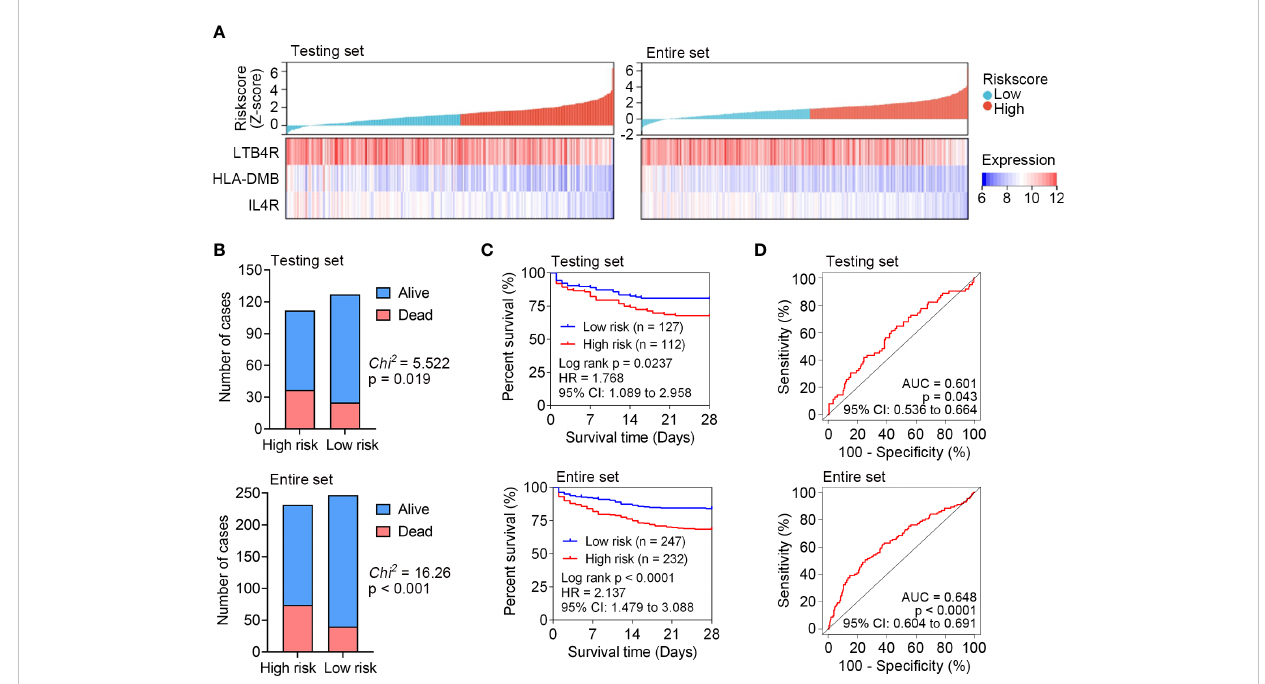
FIGURE 3 Internal test the predictive capability of IRG signature in the testing set (n = 239) and entire set (n = 479) of GSE65682. (A) The distribution of risk scores derived from the IRG signature, and the expression of the three genes that comprised the IRG signature in the testing set and entire set. (B) The distribution of 28-day survival status in the high risk and low risk subgroups in the testing set and entire set. (C) Kaplan-Meier curves of the 28-day survival based on the IRG signature in the testing set and entire set. The difference between the two curves was determined by the two-side log-rank test. (D) ROC analyses of the sensitivity and speci fi city of 28-day mortality prediction by the IRG signature in the testing set and entire set. P values were obtained from the comparisons of the AUC of the IRG signature risk score versus whose classi fi cation by 0.5